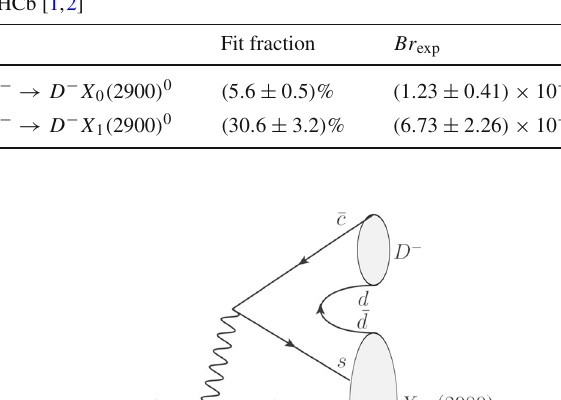
different final states, with additional d